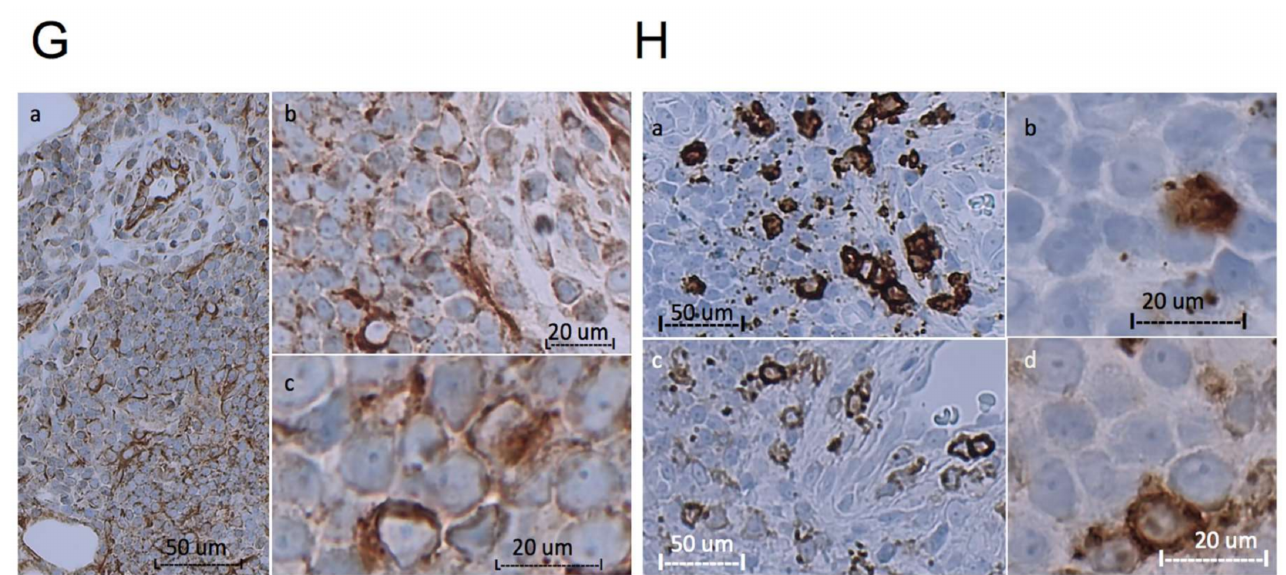
Figure 2. Photomicrographs of the 2021 skin biopsy. ( A ) Hematoxylin and eosin (H&E), Panel a, low magnification (1 × , Aperio system); panels b and c, 40 × and 63 × oil (ZEISS Axioscope.5). ( B ) CD3 (brown)/Ki-67 (magenta) dual stain; panels a, b and c, 20 × , 40 × and 63 × oil, respectively. ( C ) CD4 (brown)/Ki-67 (magenta) dual stain; panel a, low magnification (1 × ); panels b and c, 40 × and 63 × oil. ( D ) CD8 (brown)/Ki-67 (magenta) dual stain; panel a, low magnification (1 × ); panels b and c, 40 × and 63 × oil. ( E ) TIA-1; panels a and b, 20 × and 63 × oil; most of the atypical cells were TIA-1+. ( F ): Perforin; panels a and b, 20 × and 63 × oil; scant perforin-positive cells were identified. ( G ): FasL; panels a, b and c, 20 × , 40 × and 63 × oil. (H): CD8; panels a and b, 20 × and 63 × oil. CCR4; panels c and d, 20 × and 63 ×